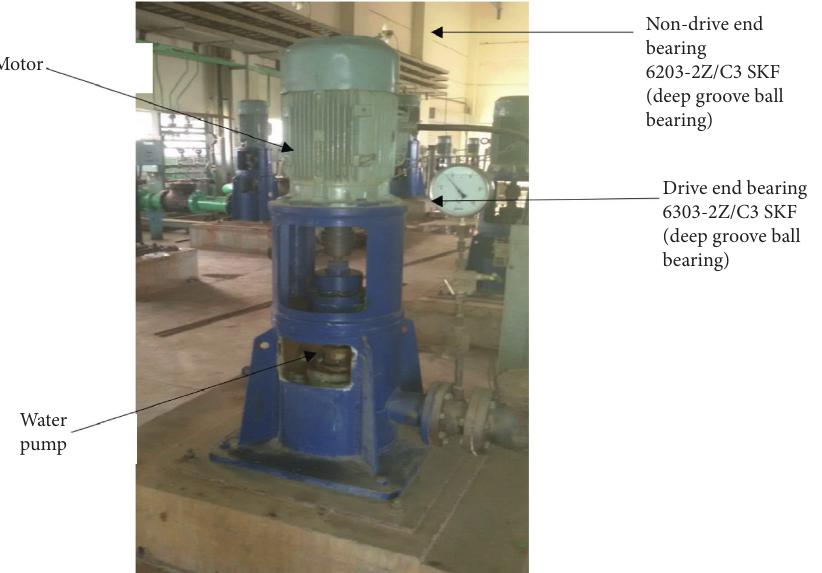
Figure 8: Experimental setup consisting of vertical electric motor of service water pump at Kosti Thermal Power